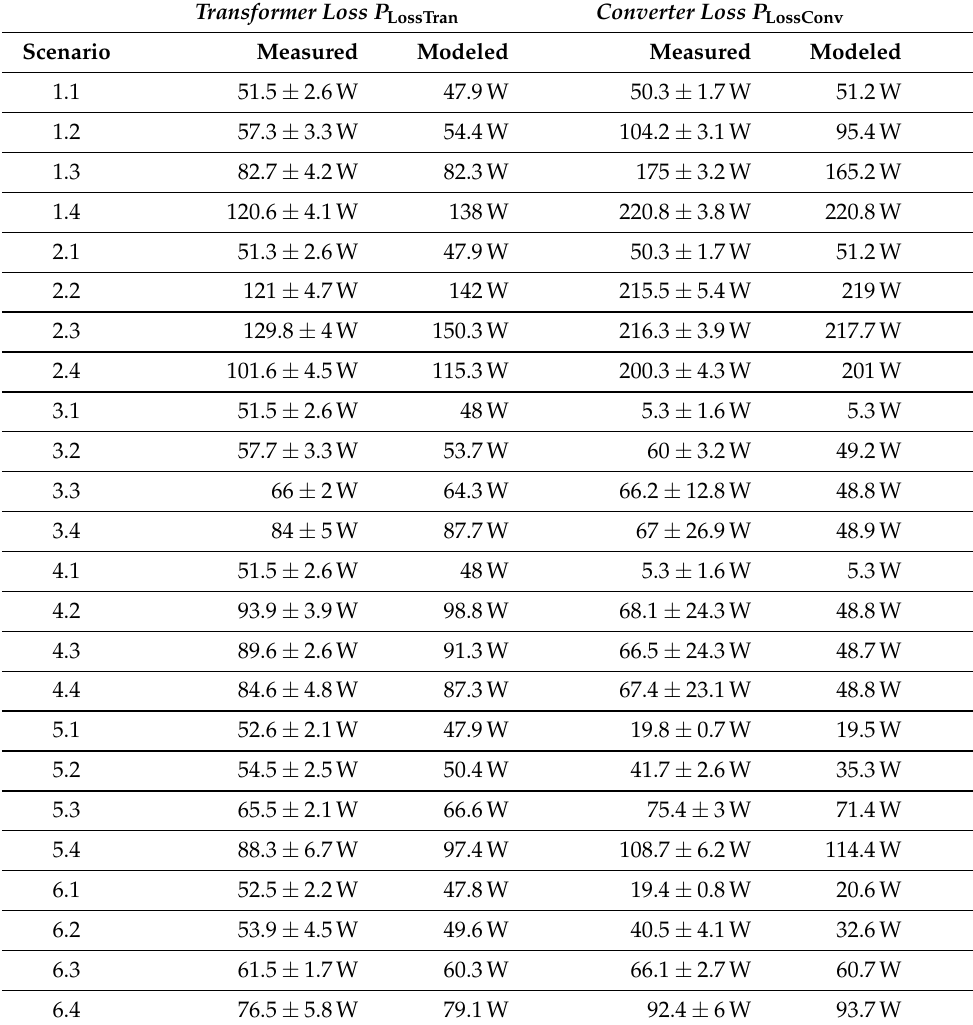
Table A3. Measured and modeled values for transformer and converter